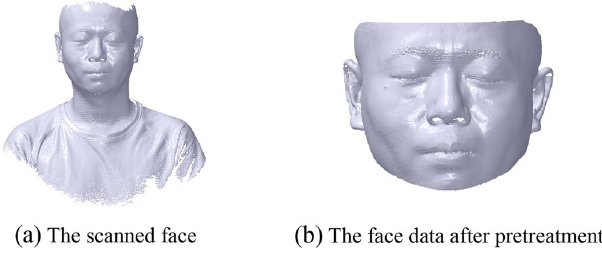
Figure 6. Pretreatment of scanned face.